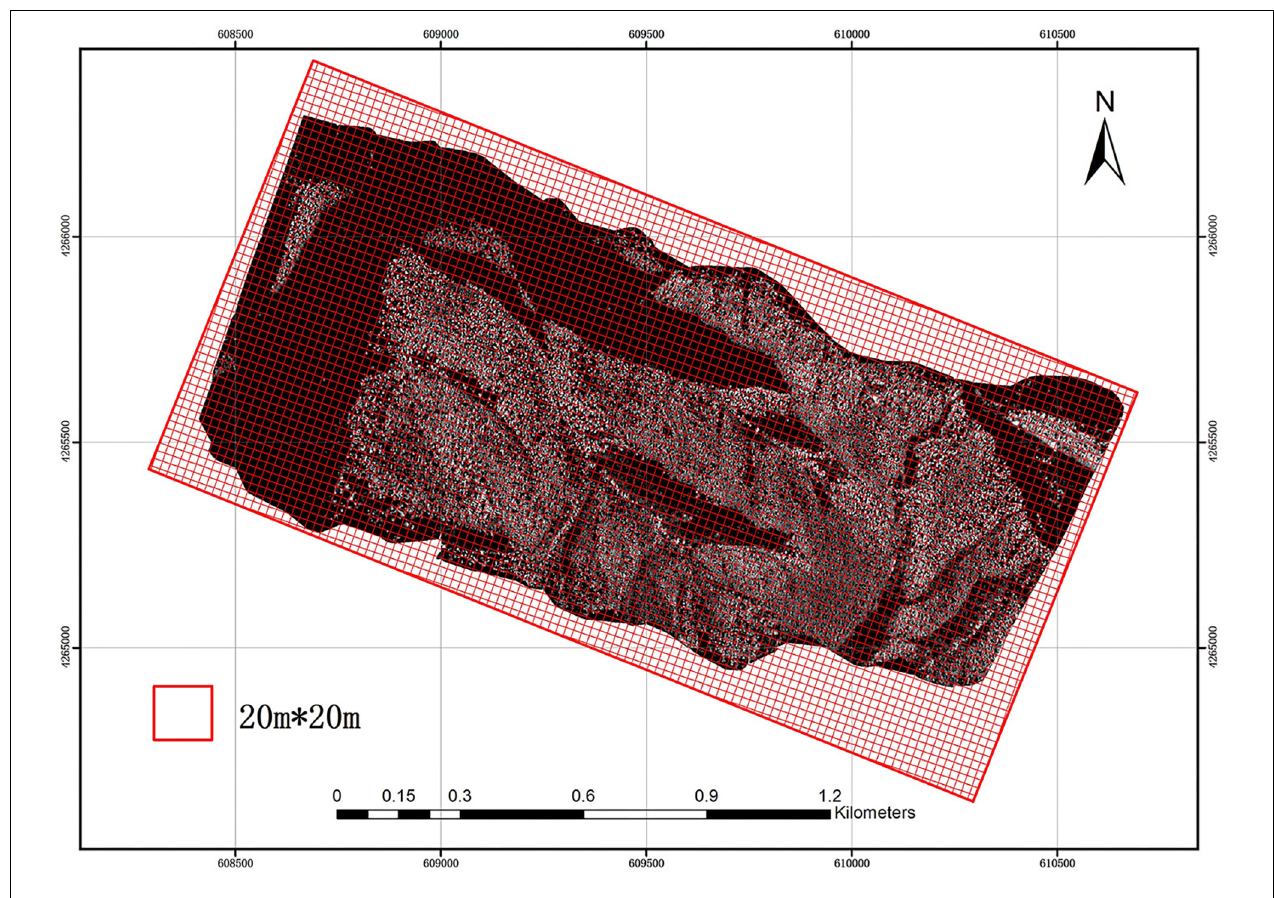
FIGURE 2 | Fishnet for the study area. TABLE 2 | Summary for ACD estimation using AvgH, LorH, and